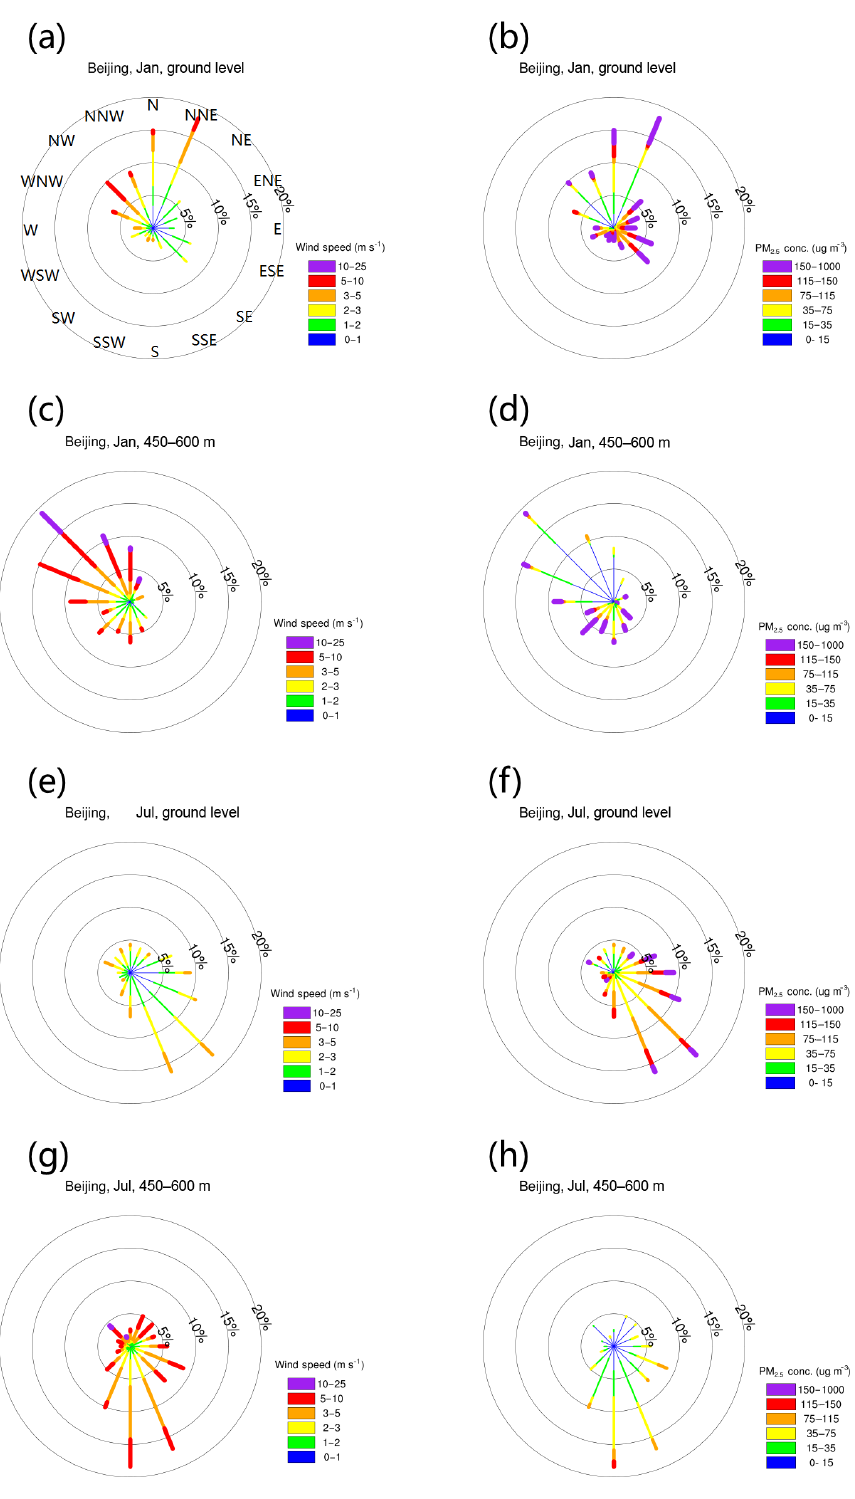
Figure 7. Wind rose plots showing the frequency of wind speed (a, c, e, g) and PM 2 . 5 concentration (b, d, f, h) at different wind directions for Beijing. The ground level and the 7th level (about 450–600m) in the model are chosen as the representation of lower levels and upper levels. The percentages denote the